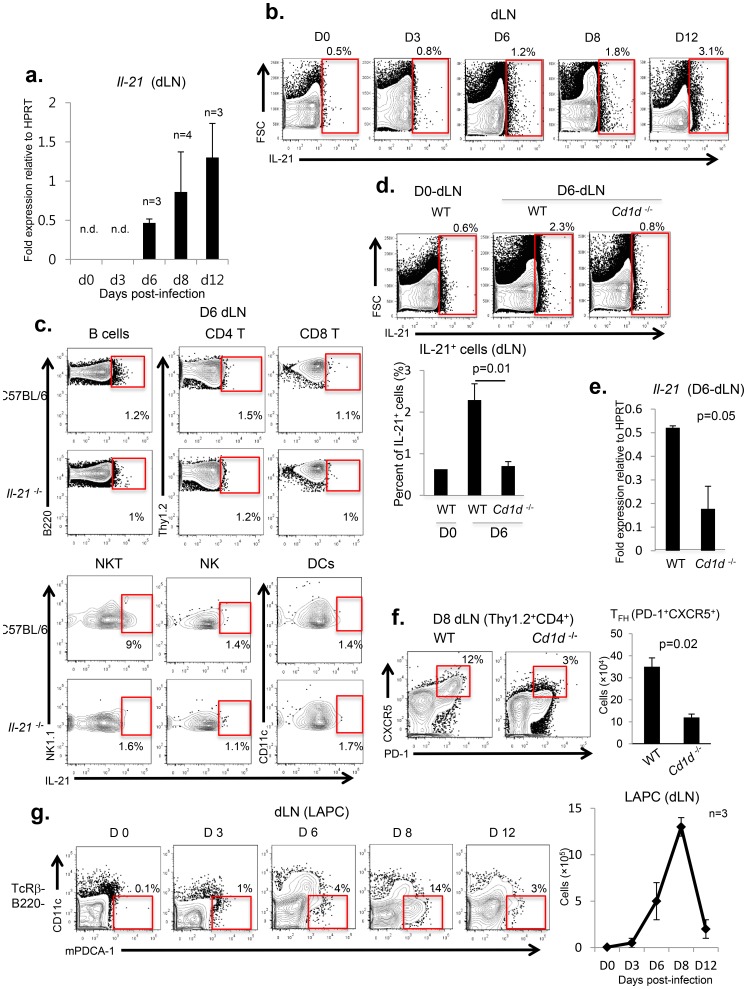
IL-21 expression and LAPC accumulation in the dLN of IAV-infected mice exhibit comparable kinetics.The tempo of IL-21 expression was examined by both (a) qPCR and (b) FACS-analysis in the dLNs of A/PR/8/34 virus infected C57BL/6 mice (n = 32). Representative data from three independent experiments are shown. (c) At 6 d.p.i., IL-21 expression was examined by FACS-analysis in each gated population isolated from the dLNs of C57BL/6 mice using IAV-infected il-21
−/− mice (n = 6) as a negative control for IL-21 gating: all cells were pre-gated for live lymphocytes based on FSC/SSC profile (B cells: B220+ CD11c−Thy1.2−; CD4 T cells: CD4+Thy1.2+; CD8 T cells: CD8α+Thy1.2+; NKT cells: NK1.1+TcRβ+CD1d+PD-1−CXCR5−: NK cells: NK1.1+TcRβ−; DCs: CD11c+Thy1.2−). For CD1d-tetramer and TFH marker (PD-1 and CXCR5) staining, either unloaded CD1d-tetramers, isotype control Abs (Rat IgG2b :RG2b) or secondary Abs (streptavidin-APC:st-APC) has been used as negative controls for CD1d-tetramer, PD-1 or CXCR5 staining, respectively. Representative data from two independent experiments are shown. C57BL/6 (n = 6) and iNKT cell deficient cd-1d
−/− mice (n = 6) were infected with 0.05 LD50 of A/PR/8/34 virus. At 6 d.p.i. the impact of NKT cell deficiency (cd-1d
−/− mice) on IL-21 production in the dLN was examined by both (d) FACS-analysis and (e) qPCR. Representative data from two independent experiments are shown. (f) 8 d.p.i., TFH response was determined in the dLN of both wild type and cd-1d
−/− mice by FACS-analysis. The data are presented as both a percentage and absolute TFH numbers (mean ± s.e.m.). Representative stainings from two independent experiments are shown. (g) C57BL/6 mice (n = 32) were infected intranasally (i.n.) with 0.05 LD50 of A/PR/8/34 virus, as described in the Materials and Methods. At the indicated days after infection, the extent of LAPC (mPDCA1+CD11c−B220−TcRβ−) accumulation within the dLNs was determined by FACS-analysis. The data are presented as both a percentage of lineage− i.e. TcRβ− B220− cells and absolute LAPC numbers (mean ± s.e.m.). Representative stainings from at least three independent experiments are shown.